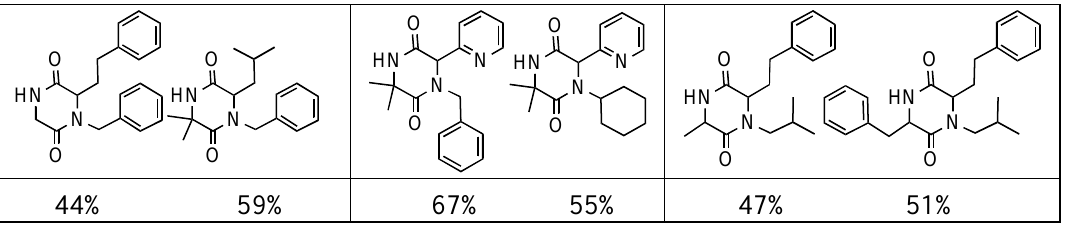
Table 1. The Ugi-DC diketopiperazine products and yields (combined 2 steps).